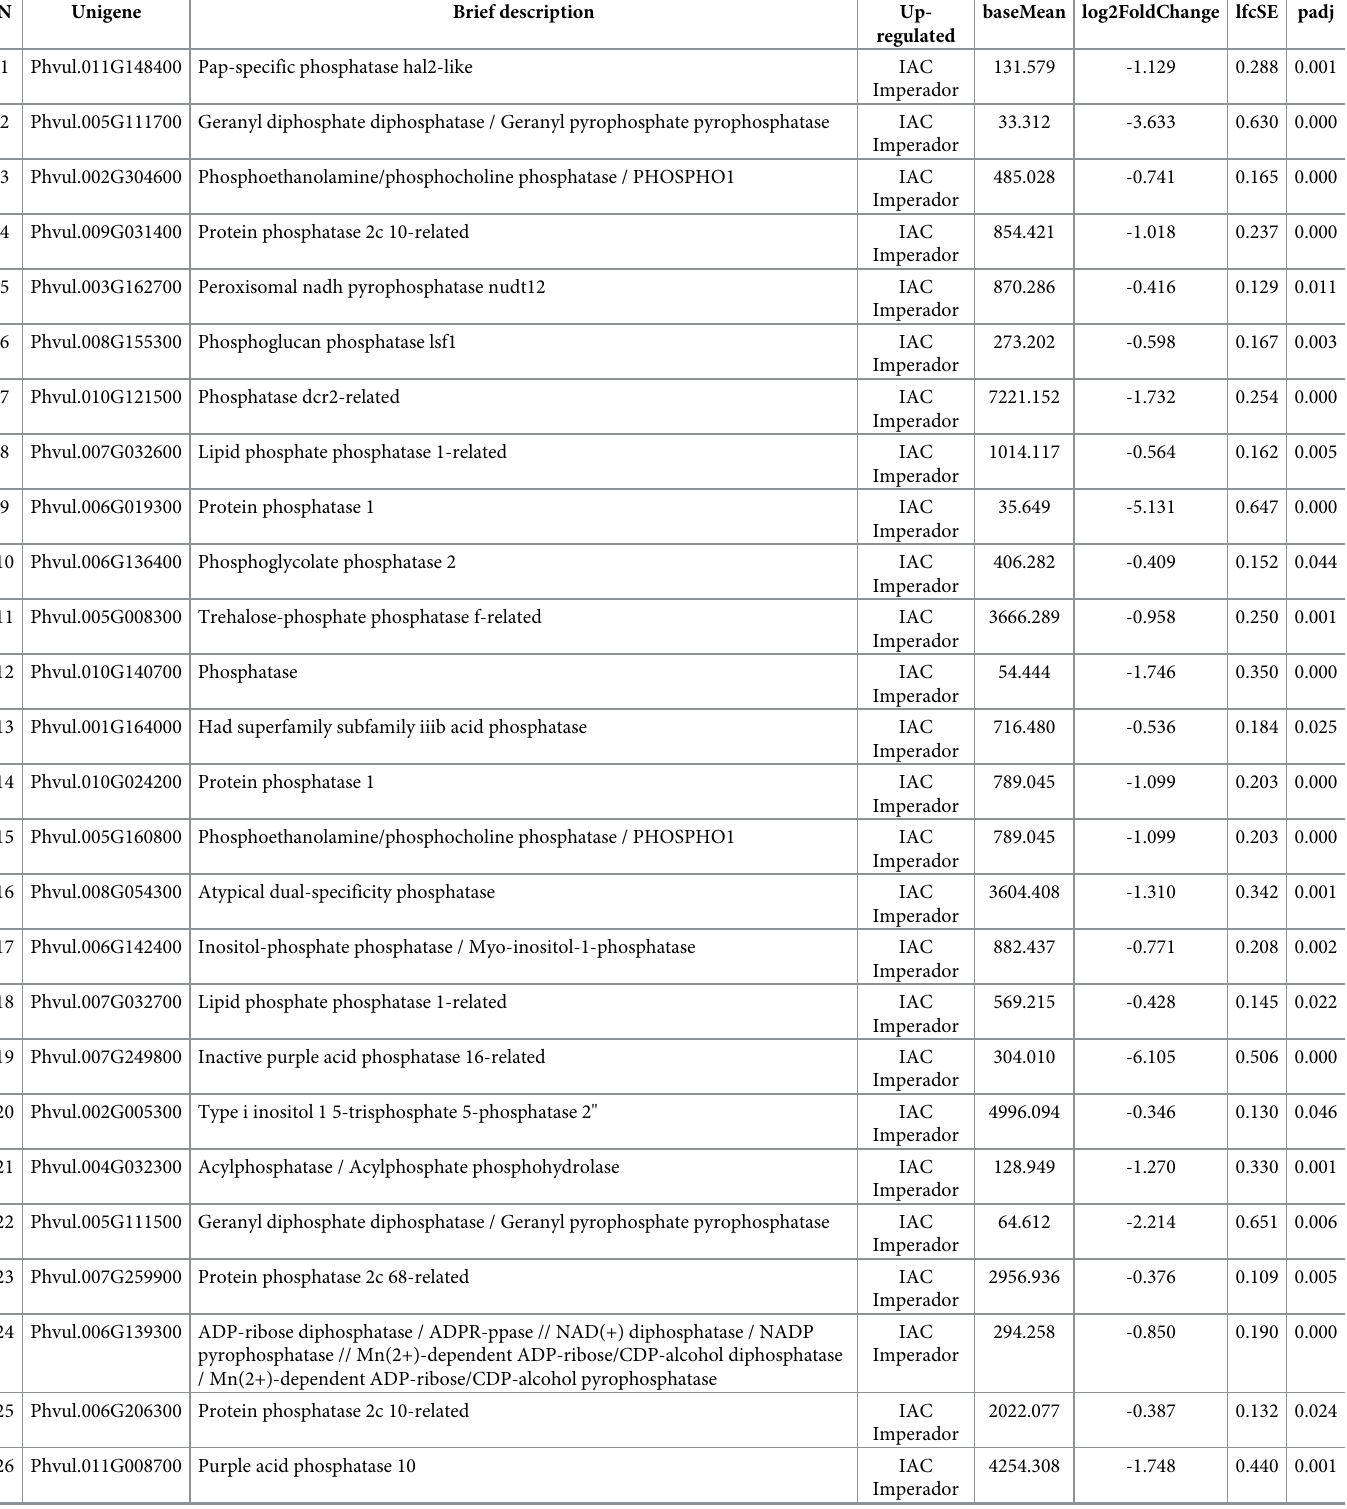
Table 6. Up-regulated phosphatase related unigenes in IAC Imperador and DOR 364 under phosphorus restriction. N